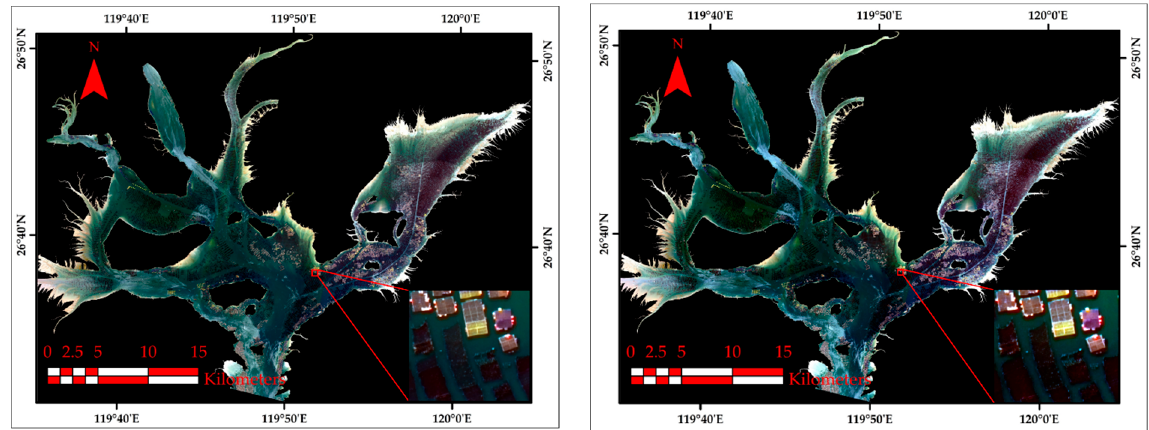
Figure 6. Image before ( left ) and after ( right ) piecewise linear stretching.